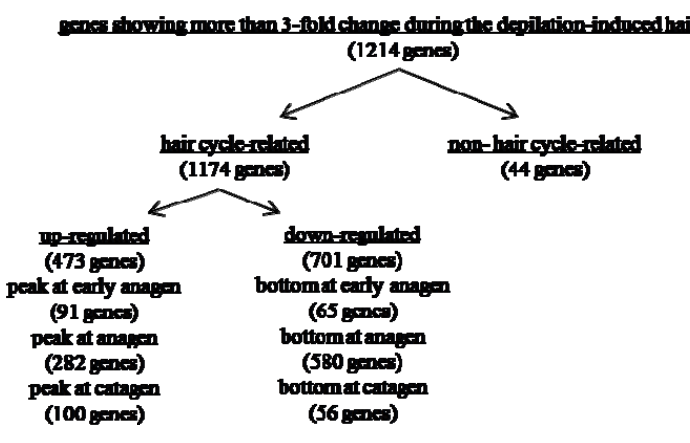
Figure 4. The number of genes showing the highest or lowest expression at each phase of hair cycle in dorsal skin of male Mini rats after depilation of telogen-phase hairs at 10 weeks